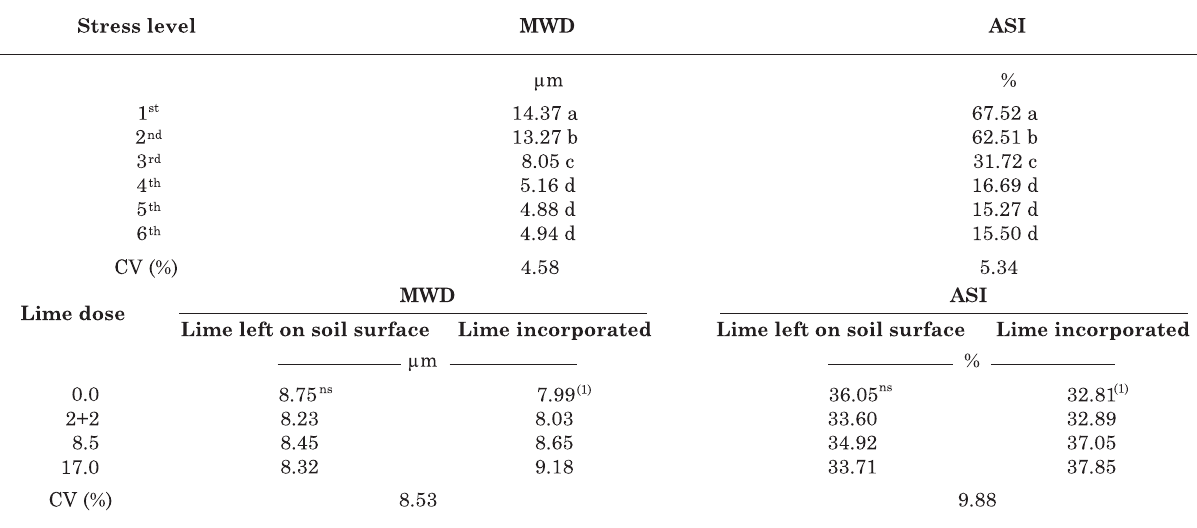
(1) Indicate needs of the regression analysis, means from quantitative treatment statistically significant. Means followed by the same letter in the given column are not statistically different (Tukey, p < 0.05). CV is the coefficient of variation expressed in percent; ns is not significant at p < 0.05 in variance